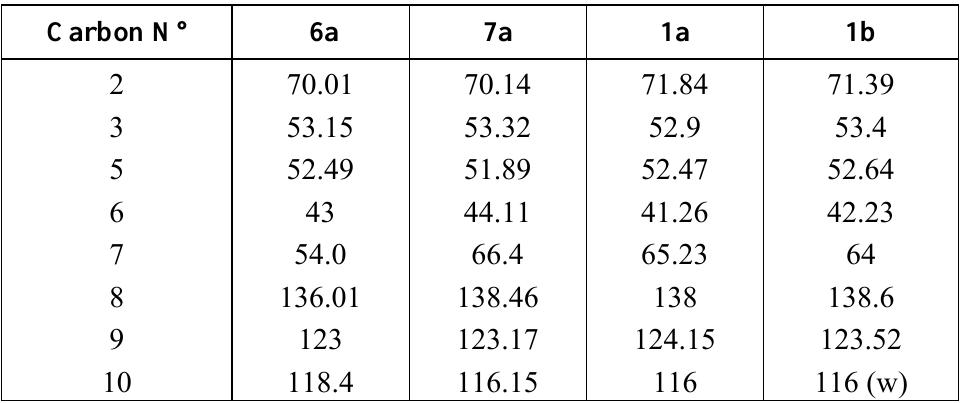
Table 1 . 13 C -NMR